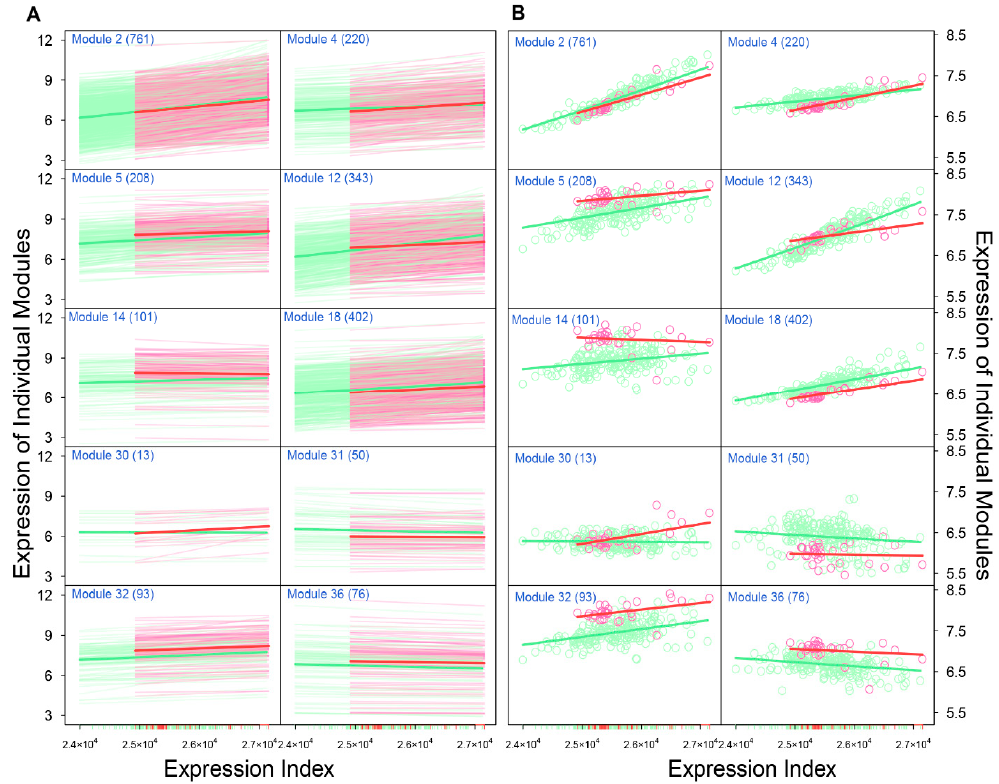
Figure 3. Distinct EI-varying pattern of ten chosen modules separately for high- (green) and low-risk groups (pink). ( A ) Power fitting of each gene within a module, shown as the change of gene expression across the EI. Each thin line represents a gene and thick lines stand for the mean fitting of all genes from the same modules. ( B ) Observed expression change of genes within a module across the EI (dot), fitted by the power equation (line).